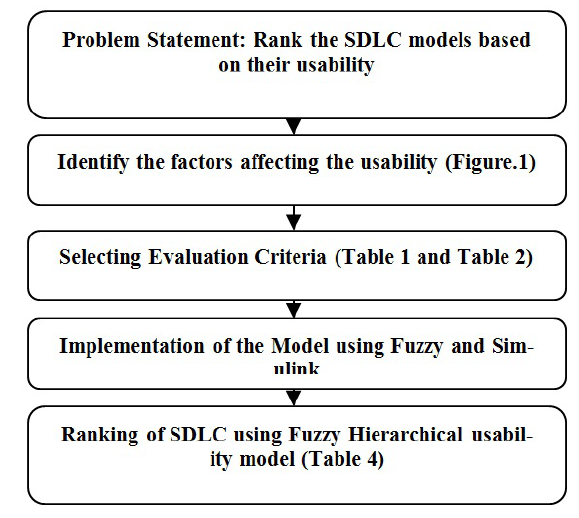
Figure 2: Steps for implementing the proposed